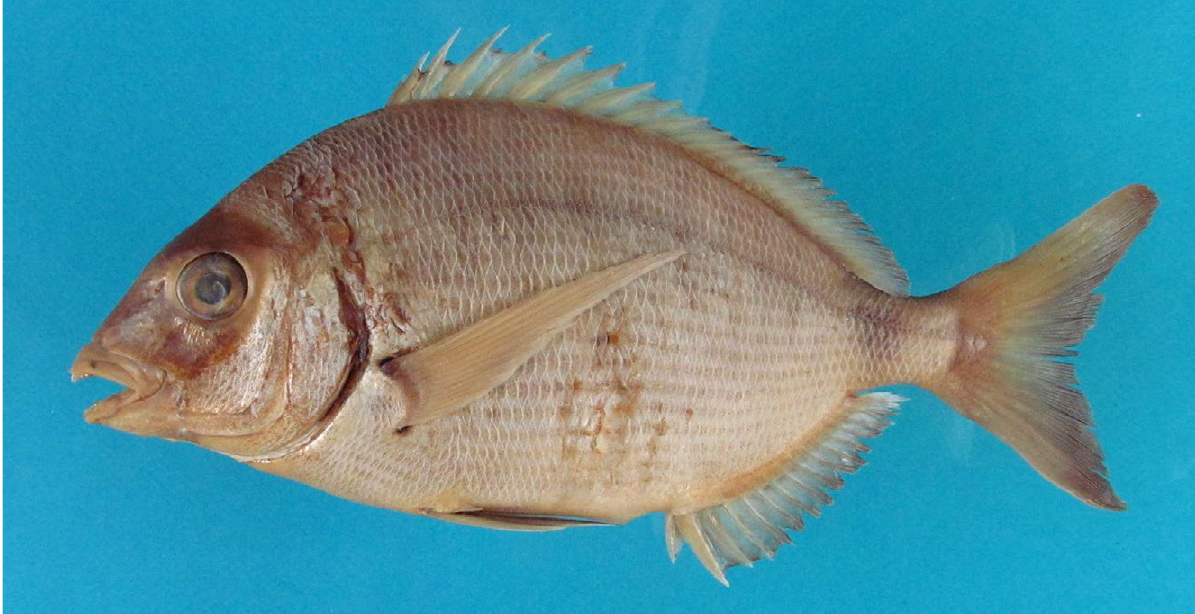
Fig. 3. – Diplodus levantinus n. sp., HUJ 2134, paratype, 176.3 mm SL, near mouth of Wadi Hadera, Israel, 24 Oct. 1955. Lateral view; photograph of the colouration in preservative taken 60 years after preservation (Photograph: D. Golani).